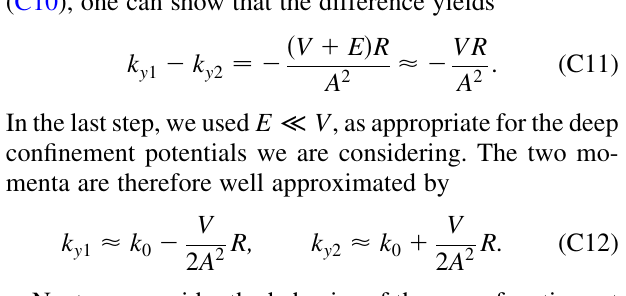
FIG. 9. Oscillating behavior for components of one of the ¼ 0 wave functions evaluated at y ¼ W= 2 , corresponding k x to the edge of the gate-defined wire. In the plots, U is the voltage (cid:10) drop induced by a perpendicular electric field, (cid:13) þ E=H þ ð y ¼ W= 2 Þ and (cid:13) þ (cid:10) i(cid:2) þ ð y ¼ W= 2 Þ . The data (cid:2) þ E=H þ E=H (cid:1) E=H (cid:1) were obtained numerically by considering the n ¼ 5 band in a HgTe system with d ¼ 70 (cid:5)A , W ¼ 800 (cid:5)A , and V ¼ 0 : 05 eV